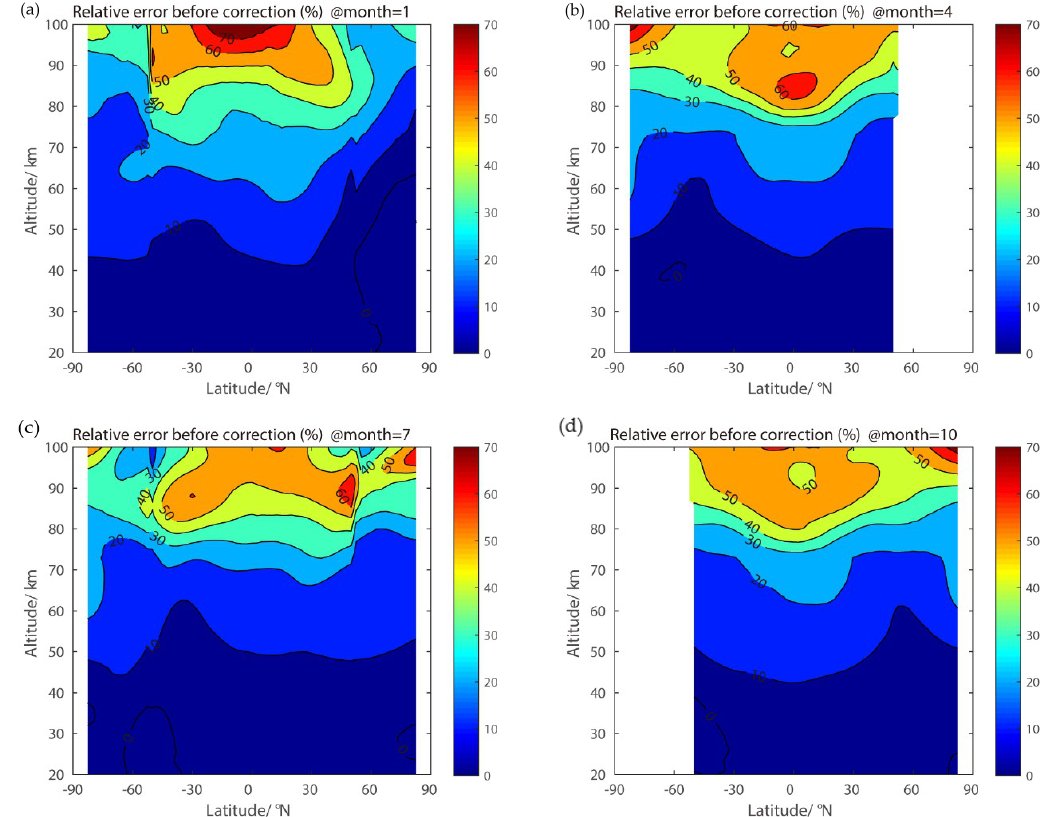
Figure 2. The latitude versus height variations of zonal mean relative difference between NRLMSISE-00 and TIMED/SABER density before correction in ( a ) January, ( b ) April, ( c ) July, ( d ) October.